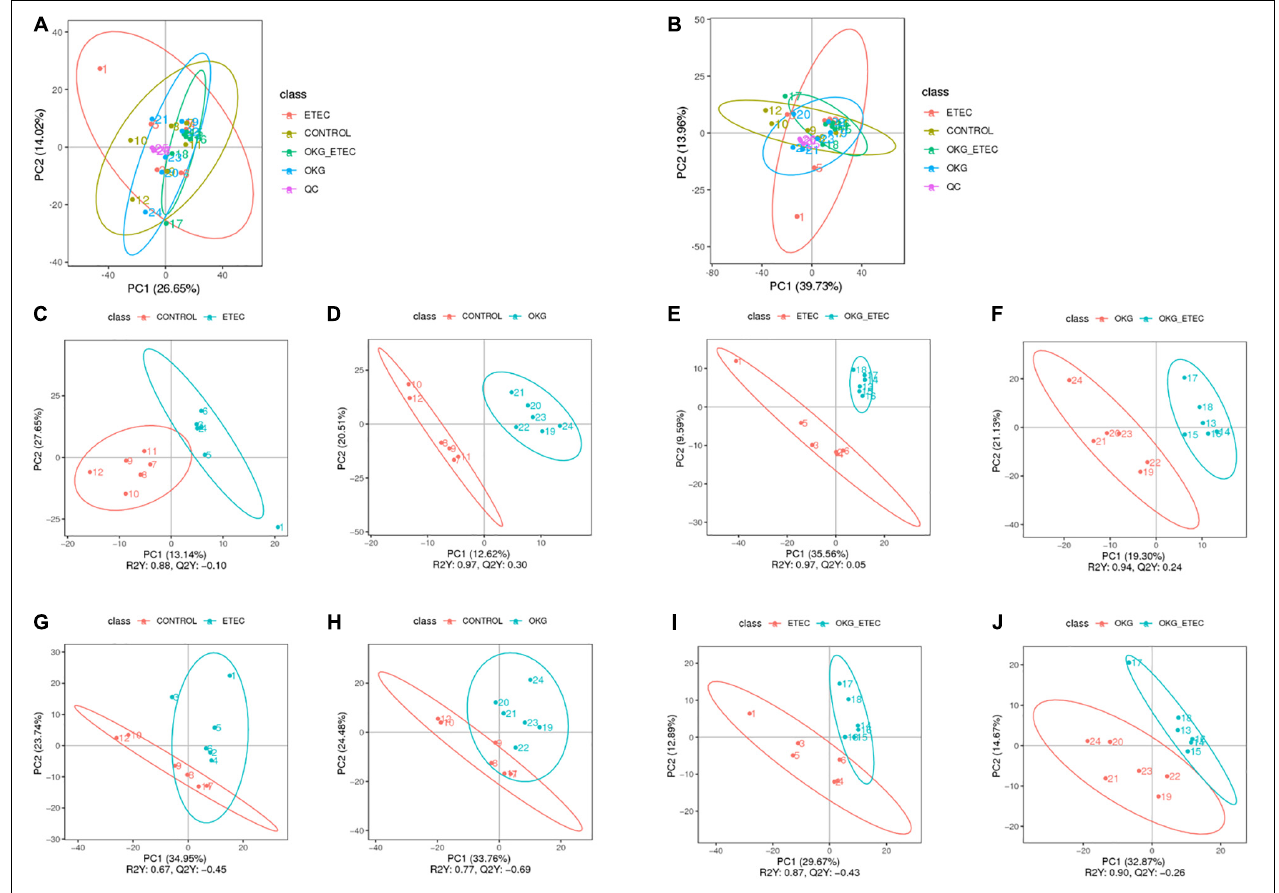
FIGURE 5 | Score plots of principal component analysis (PCA) and Partial least squares discrimination analysis (PLS-DA) models. (A,B) PCA based on positive and negative ileal mucosa metabolite profiles. (C–J) PLS-DA based on positive and negative ileal mucosa metabolite